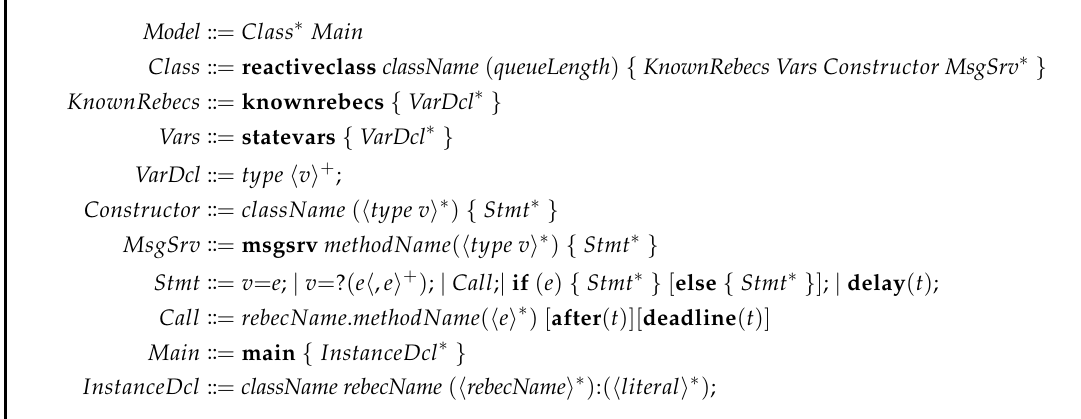
Figure 3. Syntax of Timed Rebeca (adapted from [30]). The notation is the same as that in Figure